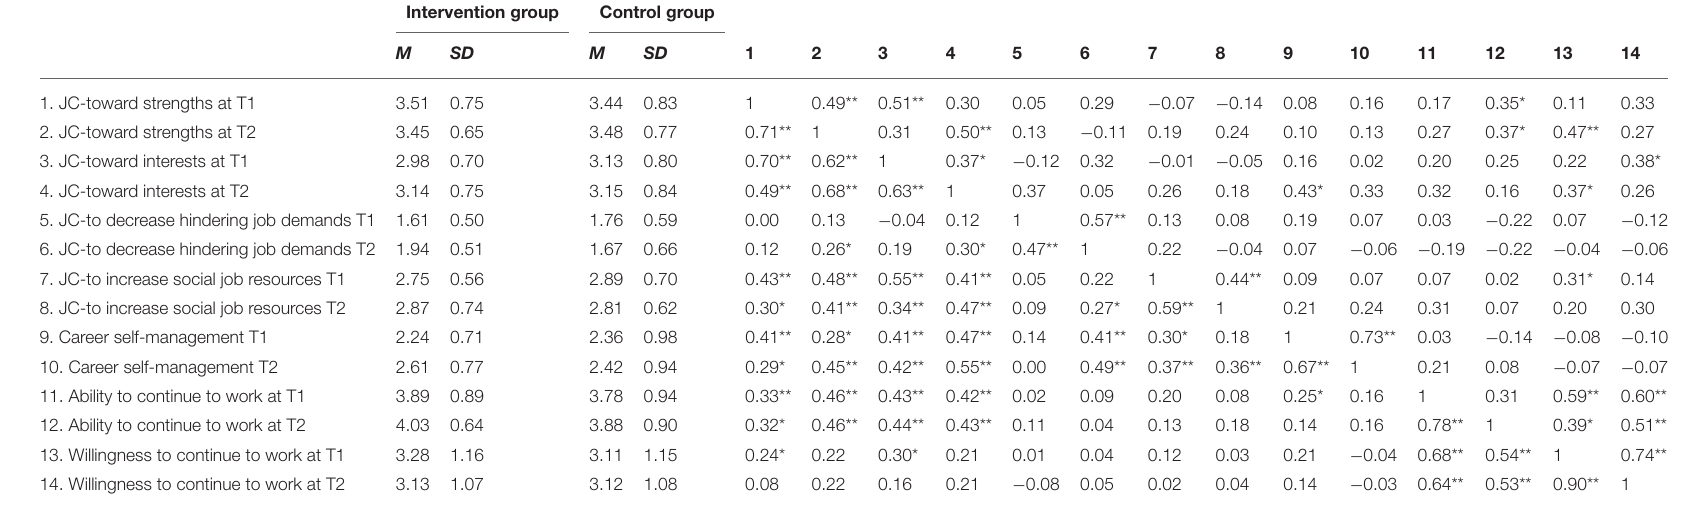
Results for the control group (n = 77) are shown under the diagonal; results for the intervention group (n = 48) are above the diagonal. * Correlation is significant at the 0.05 level (two-tailed). ** Correlation is significant at the 0.01 level